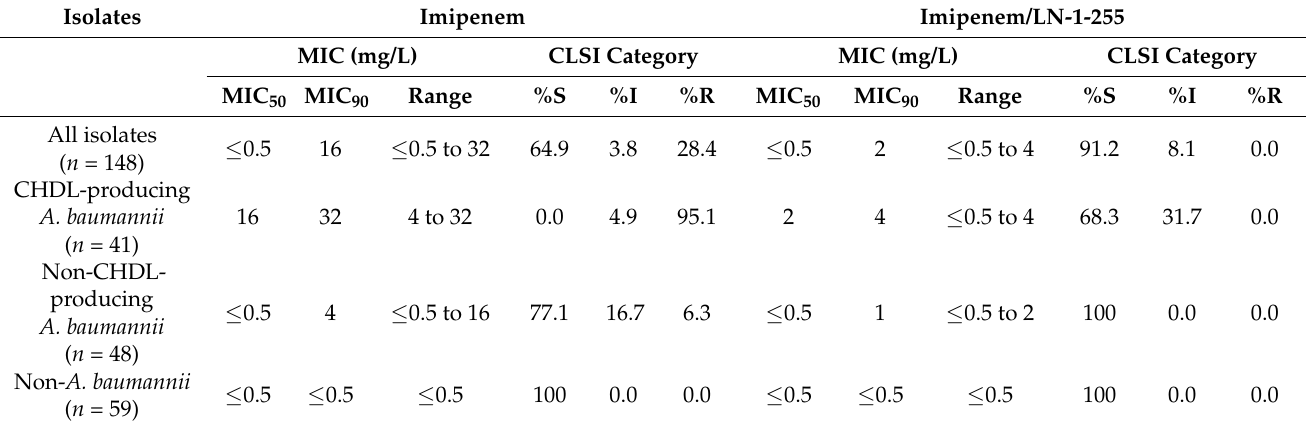
Table 1. Susceptibility of Acinetobacter spp. isolates to imipenem and imipenem/LN-1-255.